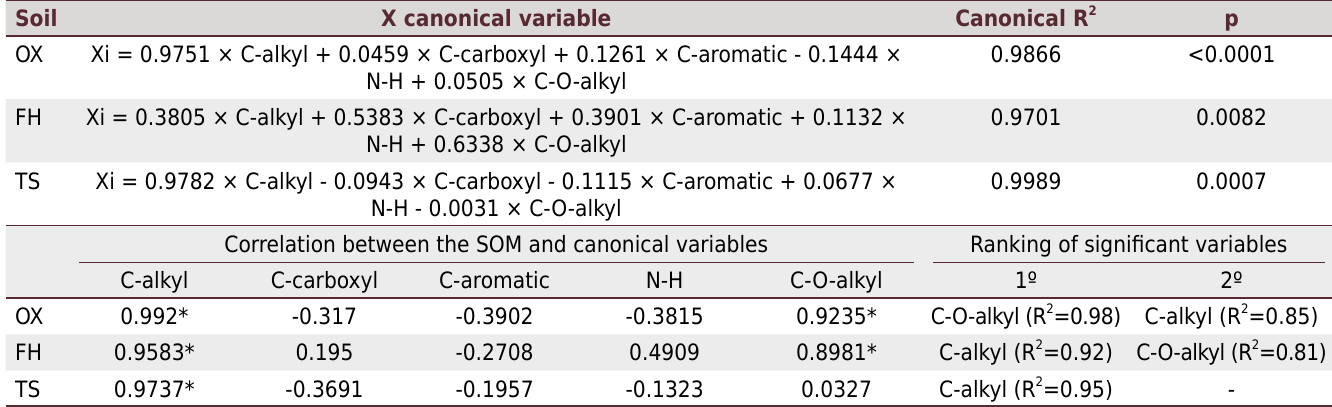
Table 2. Canonical variables produced by SOM chemical groups, canonical coefficient of determination, and significance and ranking of organic groups for each canonical variable Soil X canonical variable Canonical R 2 p